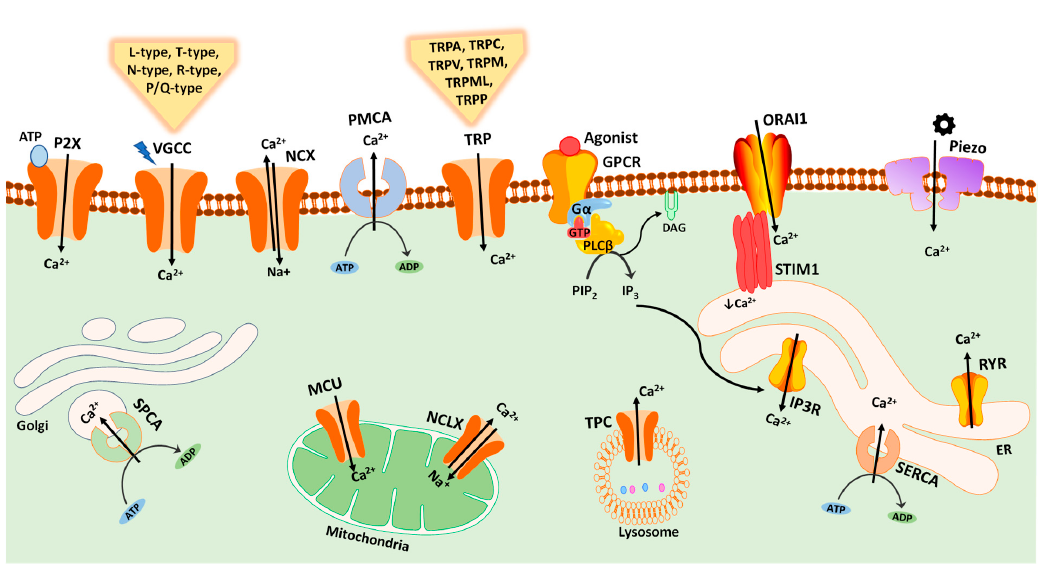
Figure 1. Schematic representation of major calcium channels, pumps, exchangers and sensors in mammalian cells. Ca 2+ influx is mediated by plasma membrane channels including transient receptor potential (TRP) channels, voltage-gated calcium channels (VGCC), ligand-gated